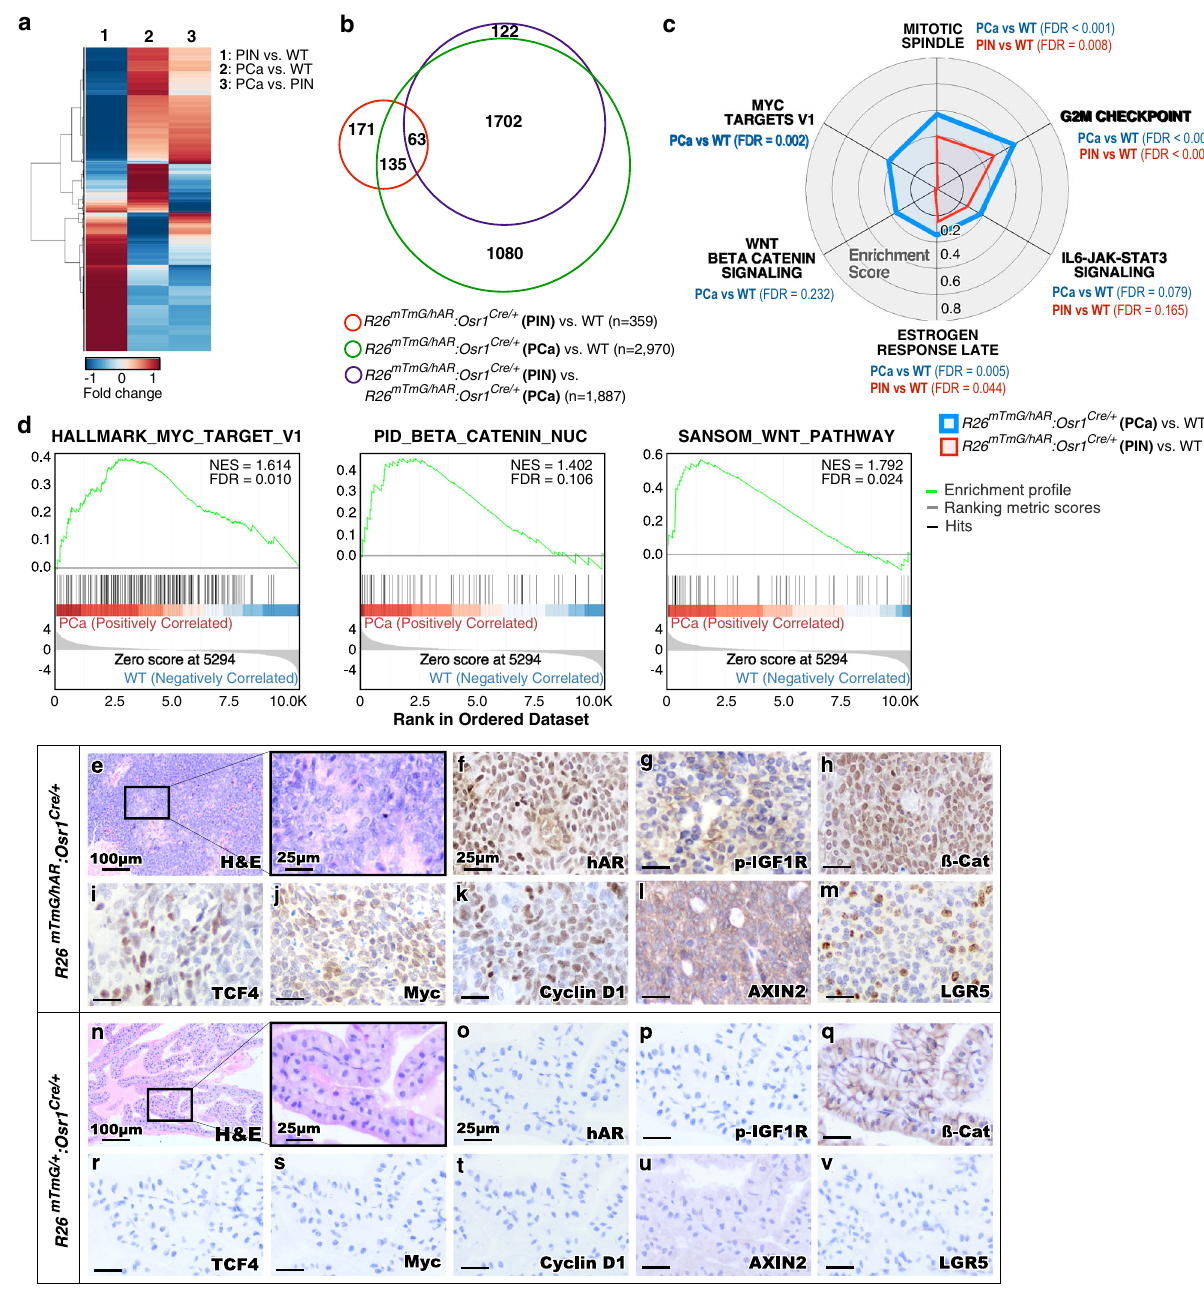
Fig. 5 | Activation of transgenic AR expression in Osr1-expressing cells upre- gulates Wnt signaling pathways in prostate tumor tissues. a Heatmap showing the expression patterns of differentially expressed genes from the three compar- isonsofbulkRNAseqdatafromnormalprostatetissuesfrom R26 mTmG/+ : Osr1 Cre/+ wild type(WT)miceandPINorPCatissuesfrom R26 mTmG/hAR : Osr1 Cre/+ miceasindicatedin the fi gure. Red and blue colors indicate up- and down-regulation, respectively. b Venn diagram depicting the number of differentially expressed genes from the different comparisons aslabeled. c Radarchart of the enrichment scoredisplaying differential enrichment of R26 mTmG/hAR : Osr1 Cre/+ (PIN or PCa) in comparison with wild type (WT) control samples. Enrichment score and false discovery rate (FDR)